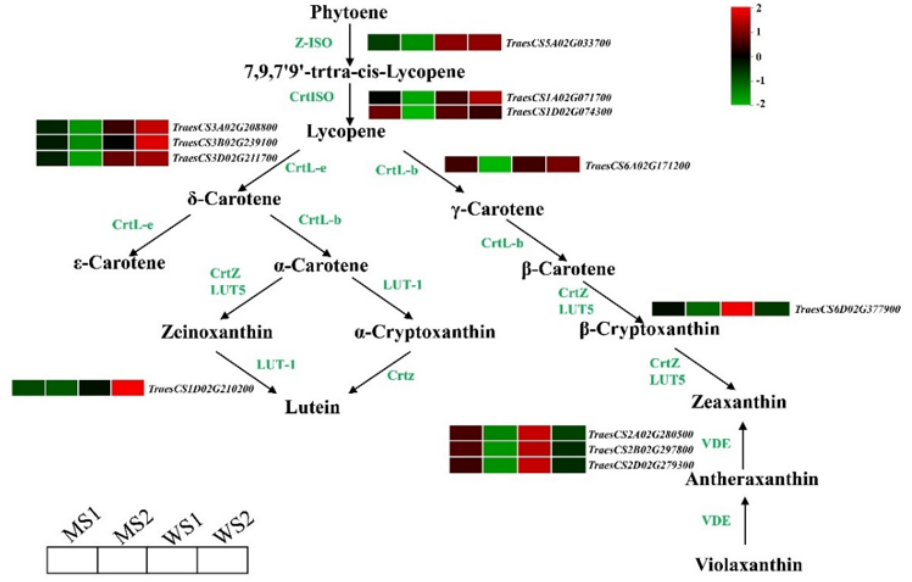
Figure 6. Carotenoid synthesis pathway.Genes are shown in different colors. Relative gene expression levels are indicated by a color gradient from low (green) to high (red). Squares are arranged from left to right: MS1 (early senescence stage of mutant), MS2 (late senescence stage of mutant), WS1 (early senescence stage of wild-type), and WS2 (late senescence stage of wild-type). Numbers in the scale bar represent normalized transcripts per kilobase million (TPM) values of genes.